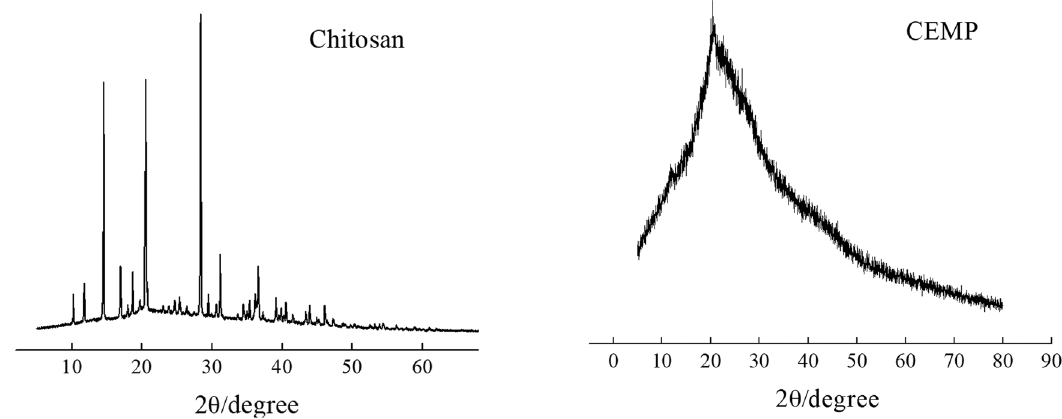
Figure 5: XRD graphs of CS and CEMP.